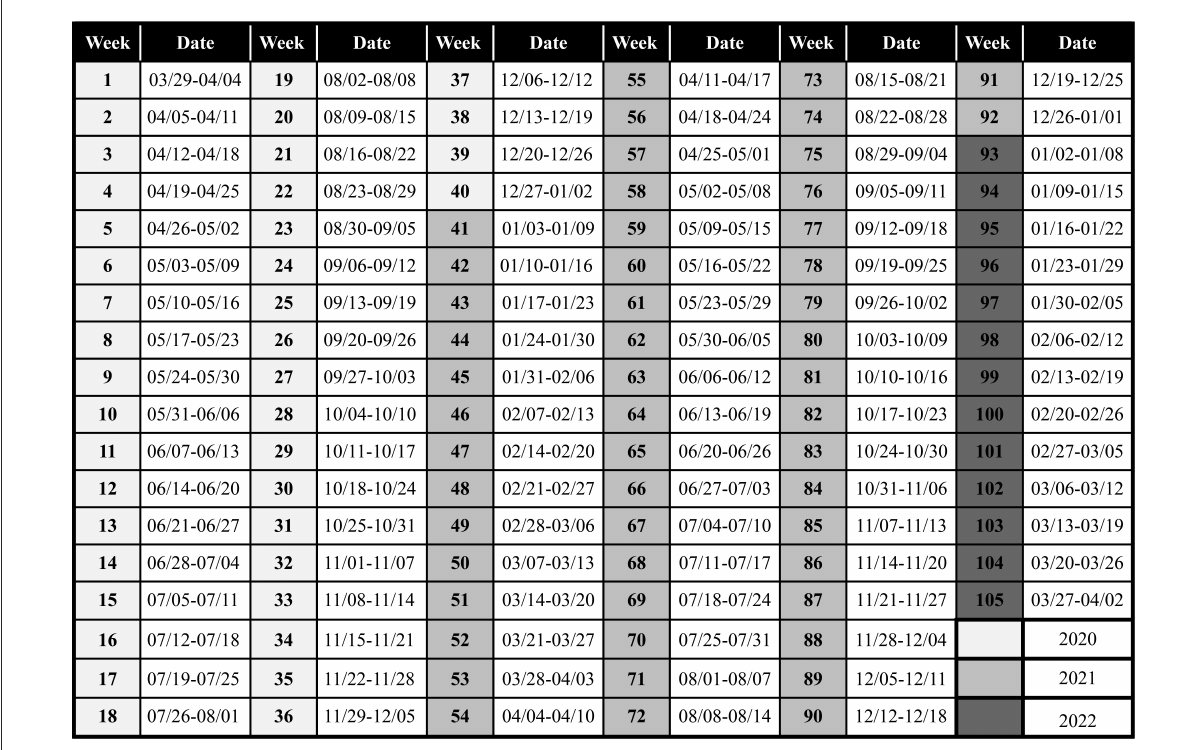
main health events related to the COVID-19 pandemic were obtained from three different sources (27, 29,